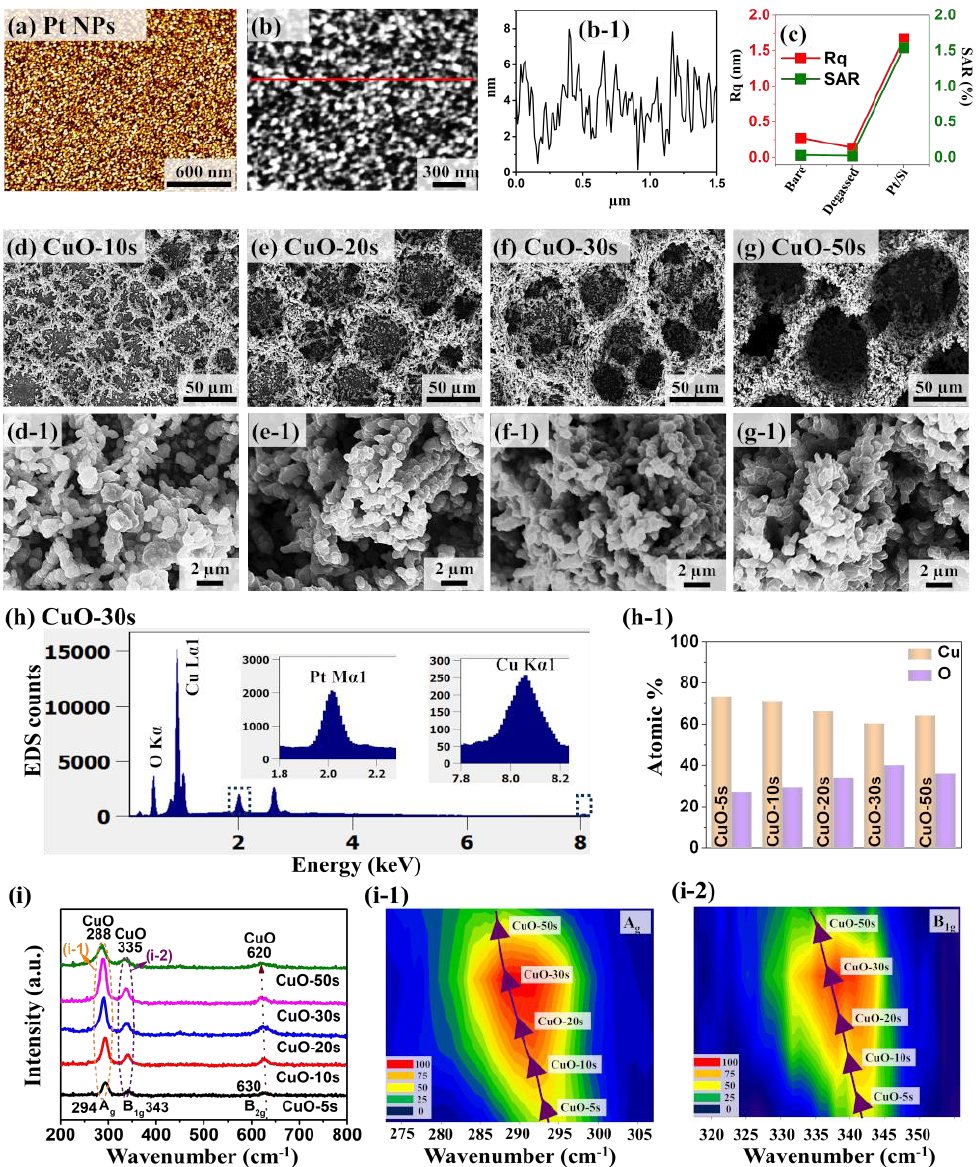
Figure 2. Structural analysis of porous CuO / Pt hybrid detectors fabricated at different deposition duration by an electrochemical deposition at 2 A / cm 2 cathodic current density in a solution of 0.1 M CuSO 4 and 0.05 M H 2 SO 4 . ( a ) Atomic force microscopy (AFM) top-view of Pt NPs on Si substrate. ( b , b-1 ) Magnified AFM top-view and corresponding cross-sectional line-profile. ( c ) Rq and surface area ratio (SAR) plots at different conditions. ( d – g ) SEM images of the porous CuO / Pt hybrid nanostructures for different deposition durations from 10 to 50 s. The CuO-10 s stands for the ten-second deposition duration. ( d-1 – g-1 ) Corresponding zoom-in SEM images. ( h ) EDS spectra of CuO-30 s. ( h-1 ) Summary of atomic percentage of Cu and O from different samples as a function of deposition time. ( i ) Raman spectra of the porous CuO / Pt hybrid samples. ( i-1 , i-2 ) Contour plots of the Raman peaks of CuO corresponding to the A g and B1 g